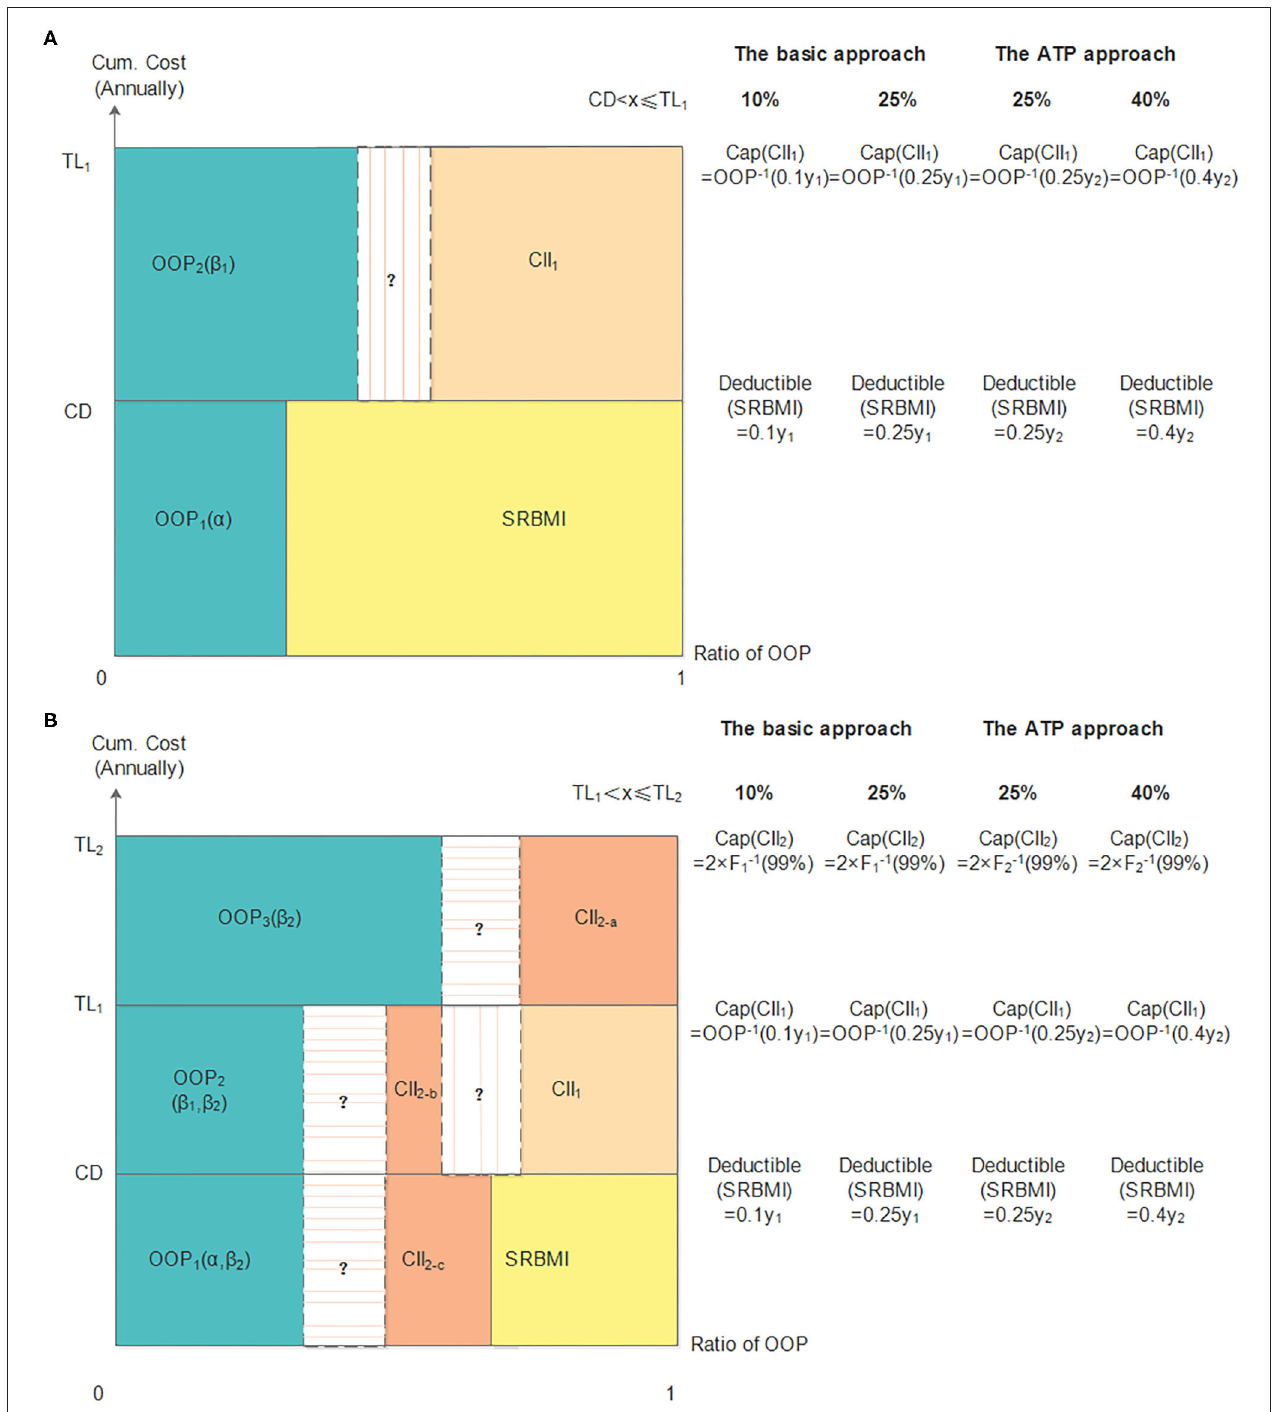
FIGURE 2 | The two-layer CII models in the basic and ATP approaches. (A) shows the first layer CII model and panel (B) shows the two-layer CII model.